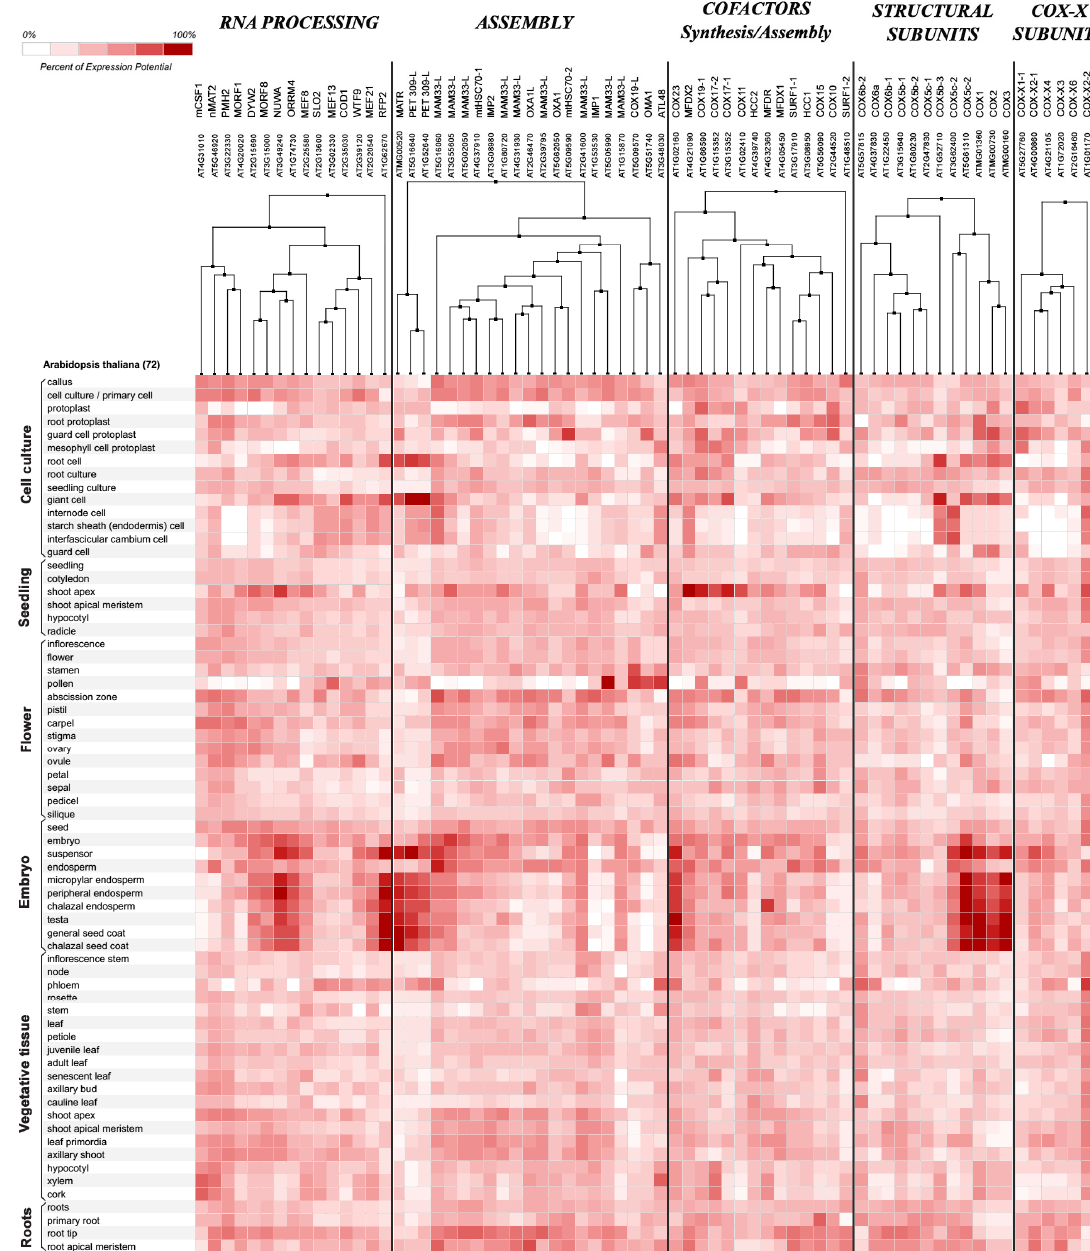
Figure 1. Hierarchical clustering of expression data across different tissues, cell types and developmental stages. Meta-analysis of the expression of genes encoding 68 COX-related proteins according to tissue- and cell-type, and in different developmental stages. Candidate proteins were classified into five different categories according to their putative or demonstrated role in COX biogenesis. Hierarchical clustering was performed within each category. Transcriptional data were collected and analyzed using publicly available microarray data included in the Genevestigator database (https://genevestigator.com/gv/doc/intro_plant.jsp, [100]). The expression level is represented as percent of maximal expression in the dataset analyzed.